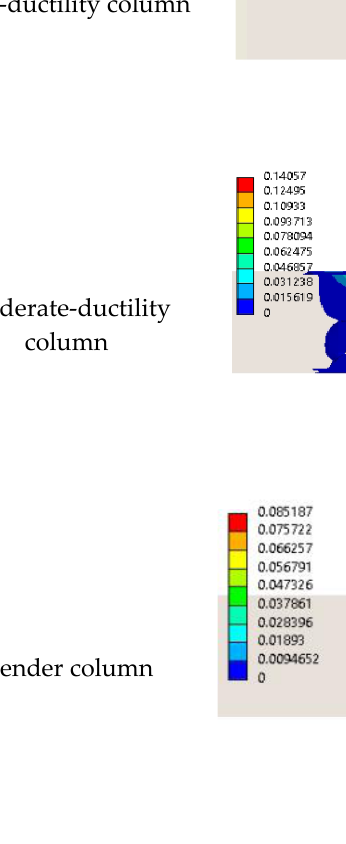
Figure 13. Plastic strain distributions in the 2BI models (Units: mm/mm).